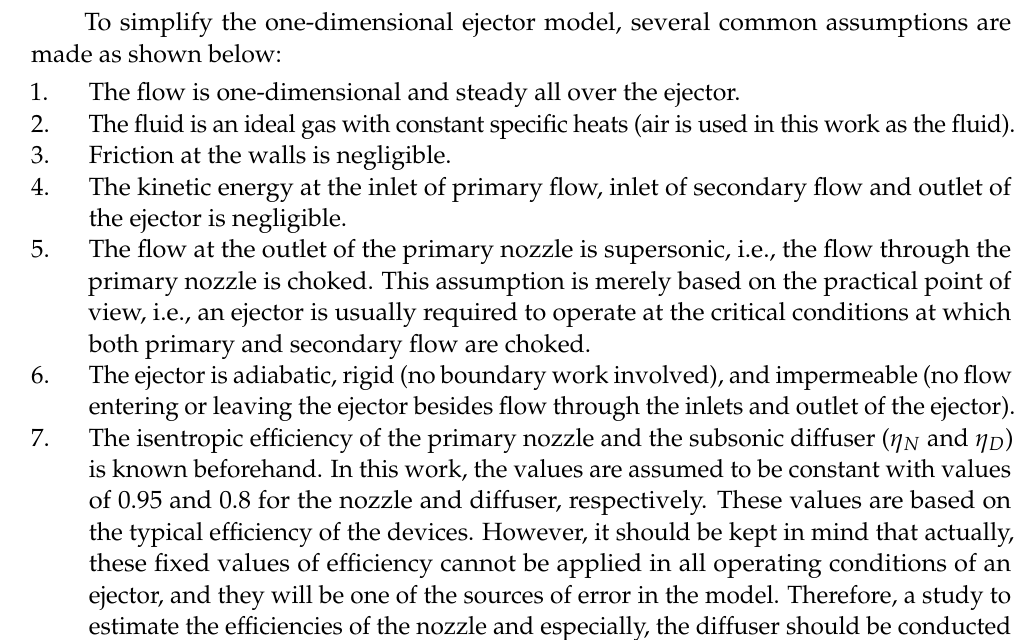
Figure 9. The Mach number contour plot for M ≥ 1 showing the periodically constricted hypothetical annular duct (turbulence model: transition SST; 𝑃 (cid:2868) = 618 kPa).